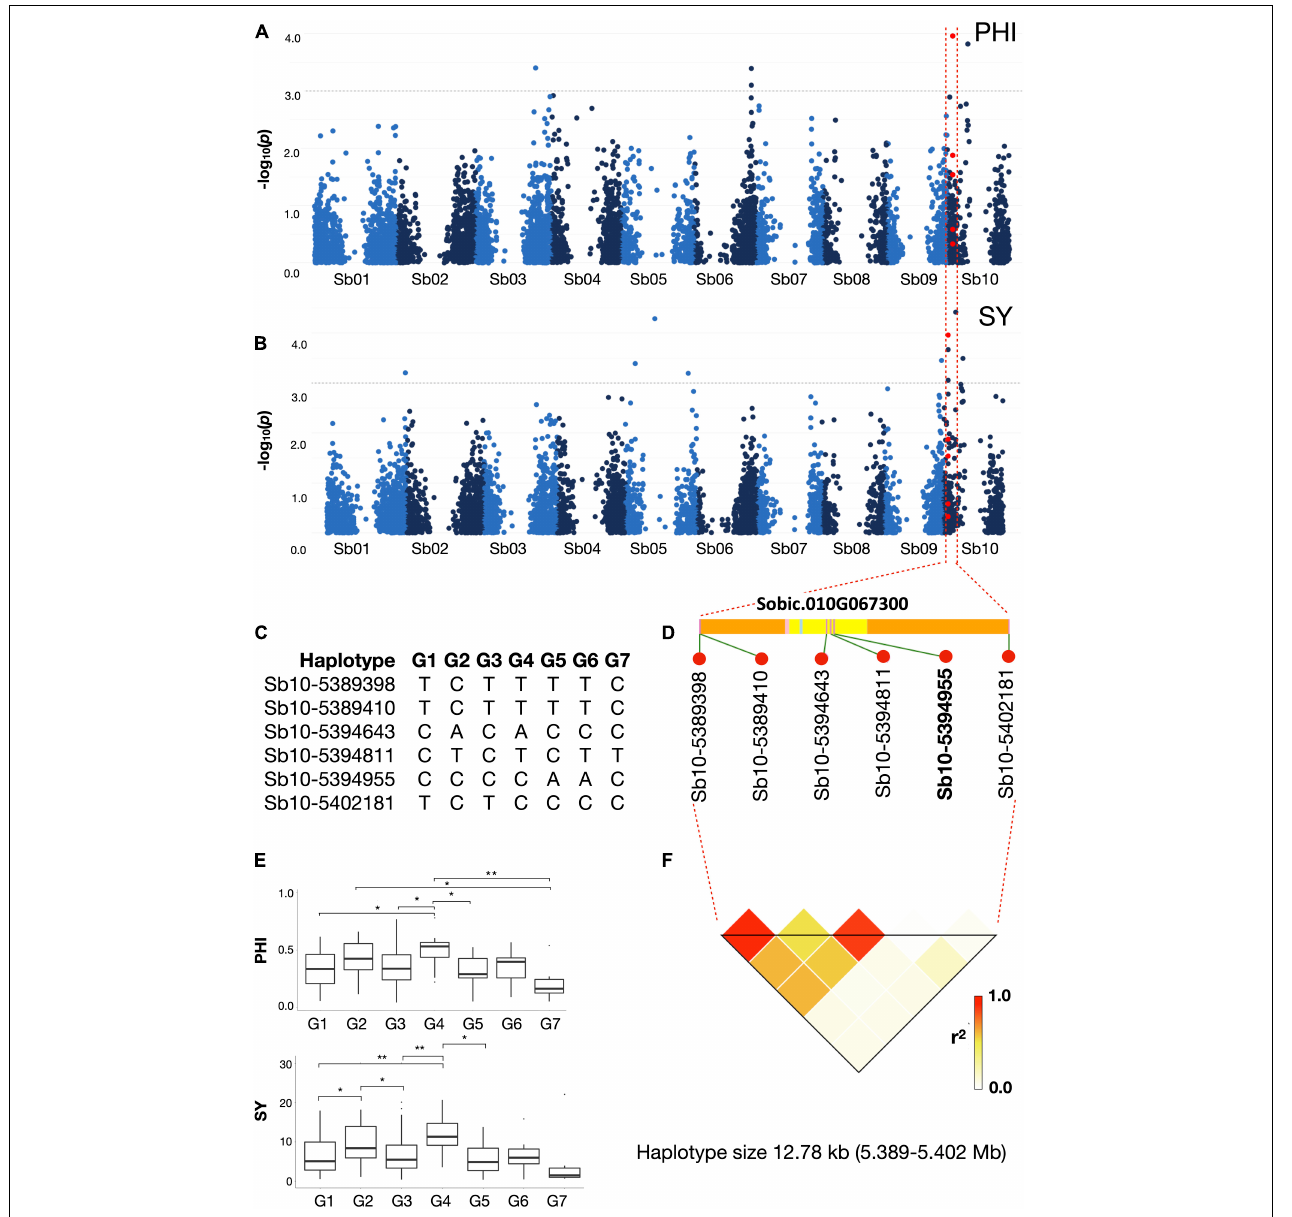
FIGURE 4 | Association mapping of (A) panicle harvest index (PHI) and (B) seed yield (SY) on chromosome Sb10. Red dots represent a haplotype region spanning just 12.78 kb (5,389,398–5,402,181 bp) including SNP marker Sb10-5394955 which is significantly associated with both PHI and SY under all combined cold stress environments. The gray dotted horizontal line indicates a threshold of genome- wide cut-off at -log10( p ) > 3.0. The SNP markers with the highest p values for each trait were used to define a haplotype region with linkage disequilibrium (LD) to the traits. (C) shows the seven haplotype groups (G1 – G7) present in the region. (D) The SNP Sb10-5394955 (marked in bold) lies in the coding region of gene Sobic.010G067300 (yellow: CDS; light blue: Intron; pink: UTR; orange: Intergenic region) and (F) shows the haploblock around this region. (E) Post Hoc result for the seven haplotype groups for traits PHI and SY. Boxplots indicate presence of significant difference between haplogroups G1-G4, G4-G3 and G5-G4 for both PHI and SY under all cold stress environments combined.